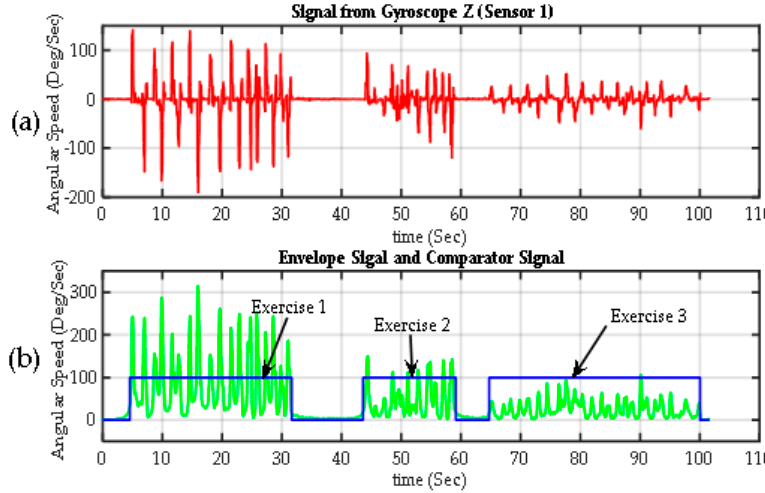
Figure 8. Segmentation of exercises. ( a ) Raw signal from one Z-axis gyroscope from Sensor 1 on the back of the hand ( (cid:1845) (cid:3008)(cid:2869)(cid:3053) ); ( b ) the envelope of the previous signal calculated using the transform Gilbert (green). The exercise detection signal (in blue), which is basically the output of a comparator, with values of 100% when (cid:3627)(cid:1845) (cid:3008)(cid:2869)(cid:3053) (cid:3555)(cid:3627) > threshold (exercise is detected) and 0% when (cid:3627)(cid:1845) (cid:3008)(cid:2869)(cid:3053) (cid:3555)(cid:3627) < threshold (rest periods). Table 3. Automatic measurements of the duration of the exercises, time, is represented in seconds.